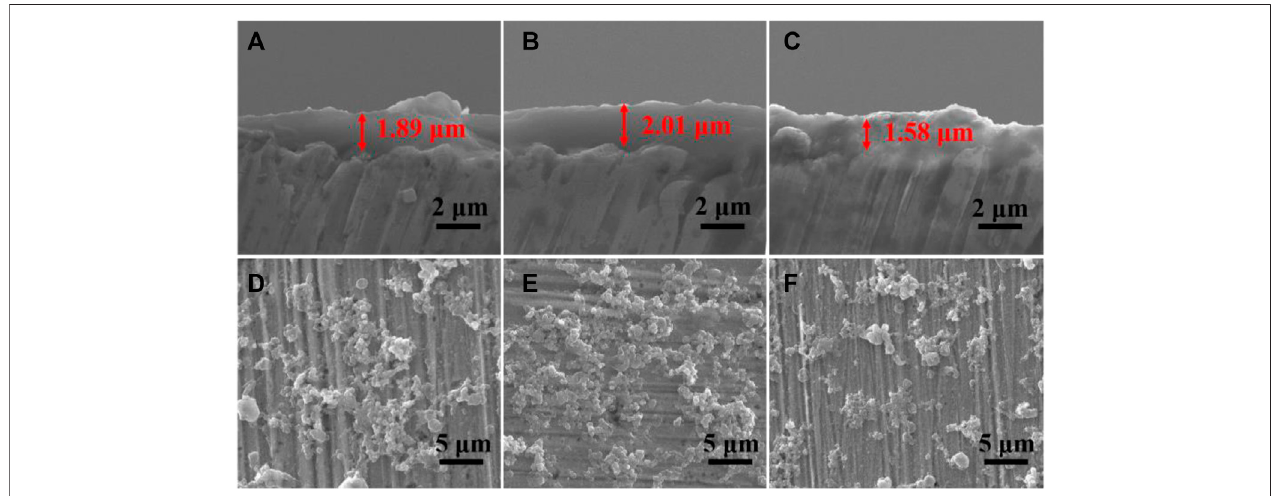
FIGURE 7 | Cross-section and top-view SEM images of PDA/TA-ALL@CS-6 coatings (A, D) ; PDA/TA-ALL@CS-7 coatings (B, E) and PDA/TA-ALL@CS-8 coatings (C, F) .